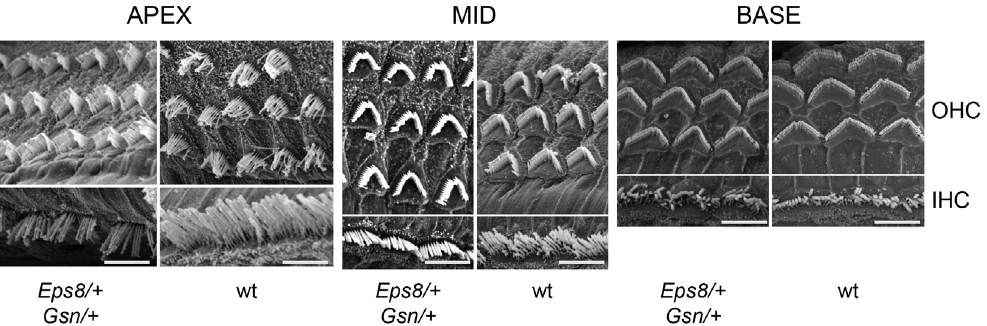
Figure 5. Ultrastructural analysis of cochlear hair cell stereocilia in Eps8-gelsolin double heterozygous mutant mice ( Eps 8tm1Ppdf / + ; Gsn tm1Djk / + ). SEM analysis of hair cell stereocilia bundles in Eps8-gelsolin double heterozygous mice and wild type litter mate controls at P27. OHCs and IHCs at the apex, mid and basal turns of the cochlea from Eps8-gelsolin double heterozygous mice showed similar hair bundles to those in wild type litter mate controls. Scale bars: 10 m